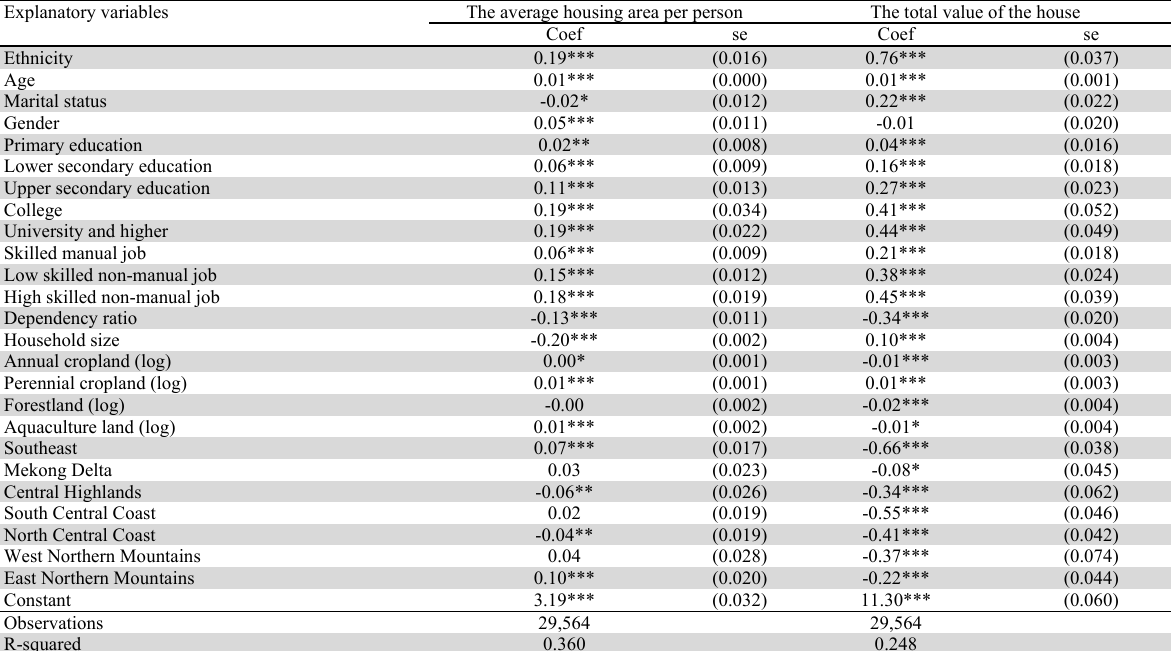
Table 2 reports the regression results from the housing area and value of the house models. Table 2 Factors associated with the value and size of the house (OLS regression) Explanatory